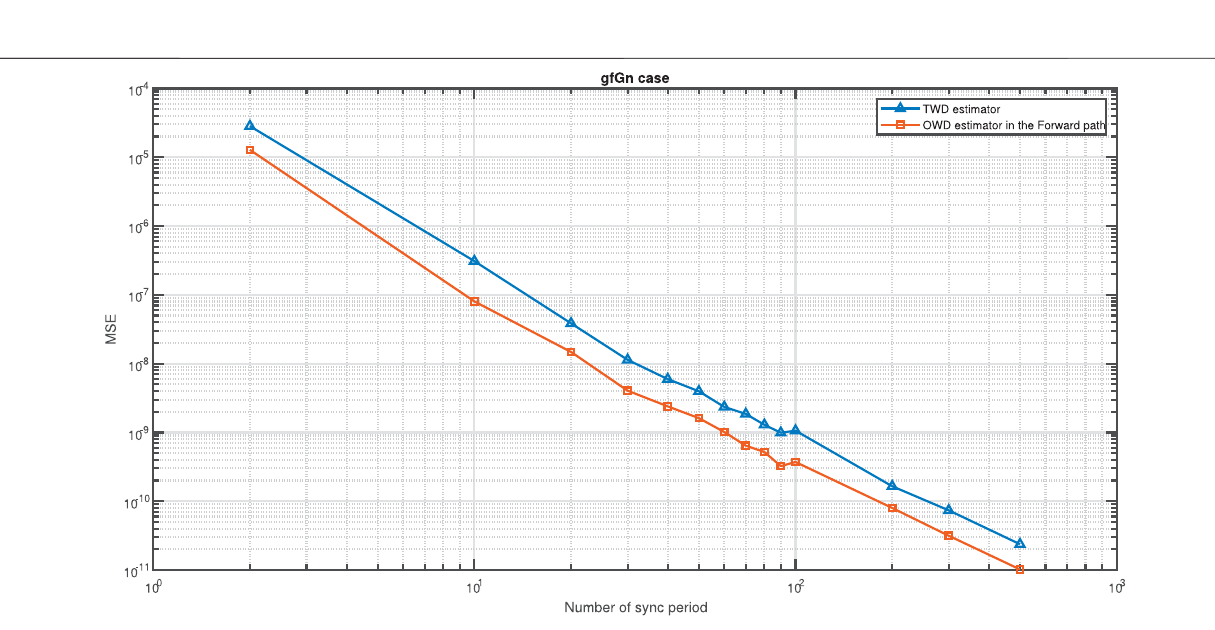
FIGURE 7 | Test case a of Theorem 8. Performance (MSE) comparison between the OWD clock skew estimator in the Forward path ( Eq. 61 ) and the TWD clock skewestimator( Eq.60 ).ThePDVisangfGnprocess. α =50 ppm , Q =5 ms , T syn (cid:2) 15 . 6 ms ( 64 packet σ 2 (cid:2) 9 e − 8 [ sec 2 ] , Z = 9, ~ Z ( J (cid:2) 500 ) (cid:2) 3 . 02 (for J < 500, ~ Z ω 2 fGn / gfGn